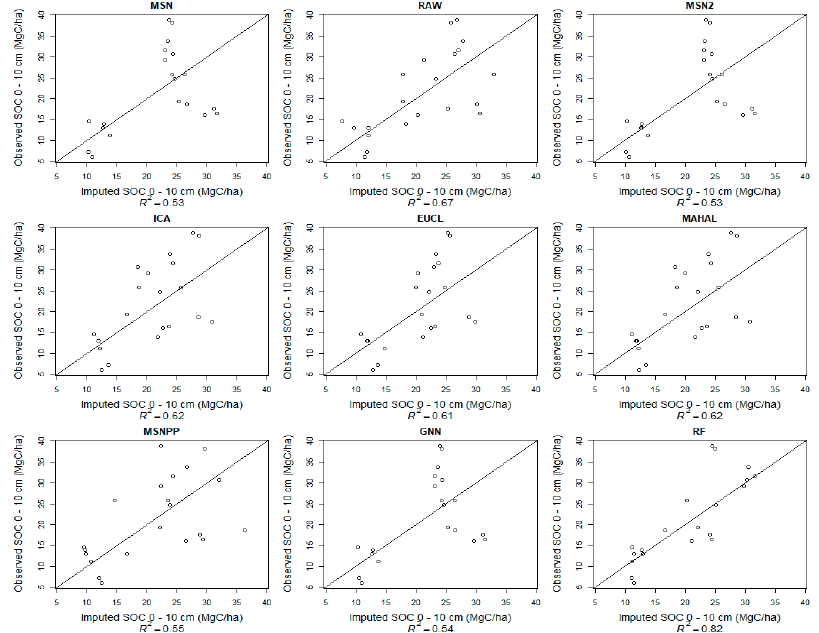
Figure 3. Bivariate relationships between the LiDAR metrics and SOC 10 (0–10 cm soil layer) C stock biomass of Pinus halepensis plantations at Los Cuadros (Murcia, Spain). In all figures, the linear 1:1 line has been fitted. For these equations, the R 2 value is included (see Table 3 for RMSE values).